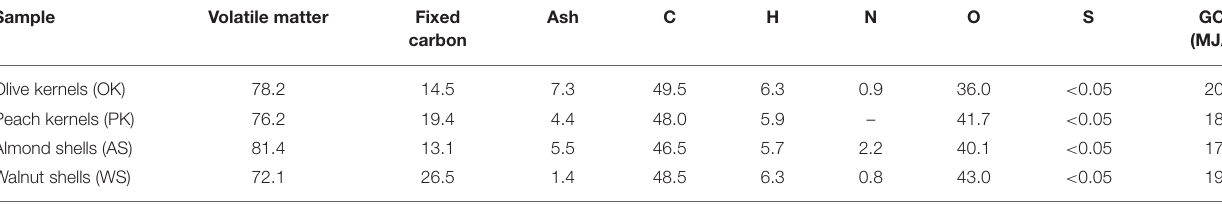
TABLE 1 | Proximate and ultimate analyses and calorific value of the samples (% dry weight). Sample